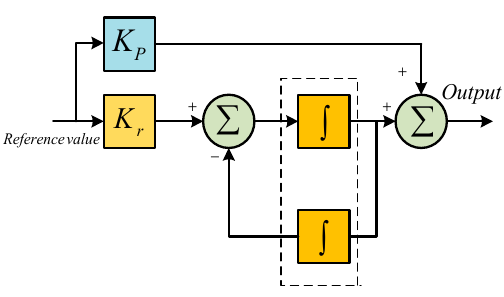
Figure 22. General structure of a PR Controller.